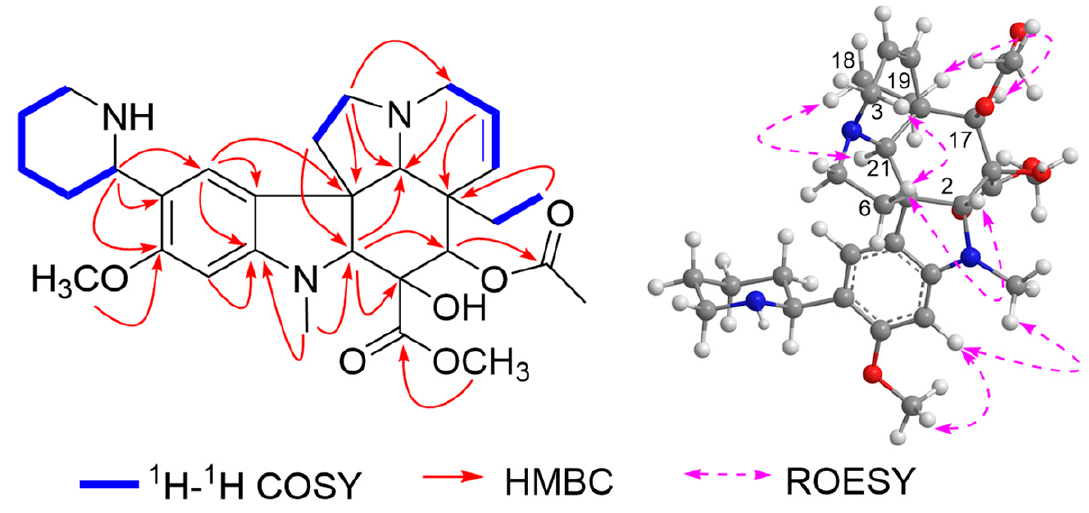
Figure 4. Key 1 H– 1 H COSY, HMBC and ROESY correlations of 2 .